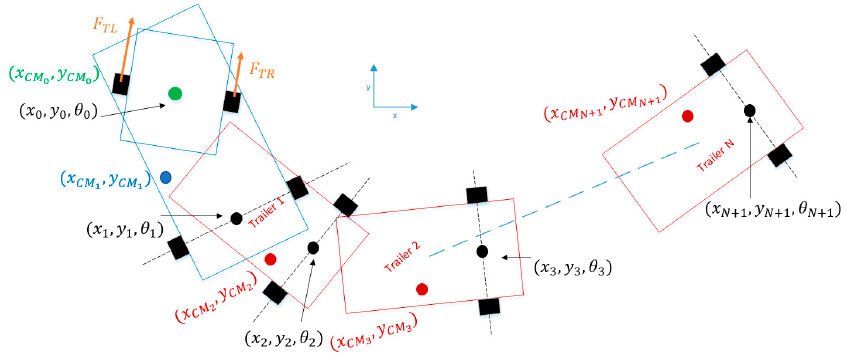
Figure 2. Multi-trailer AGV schematic representation.